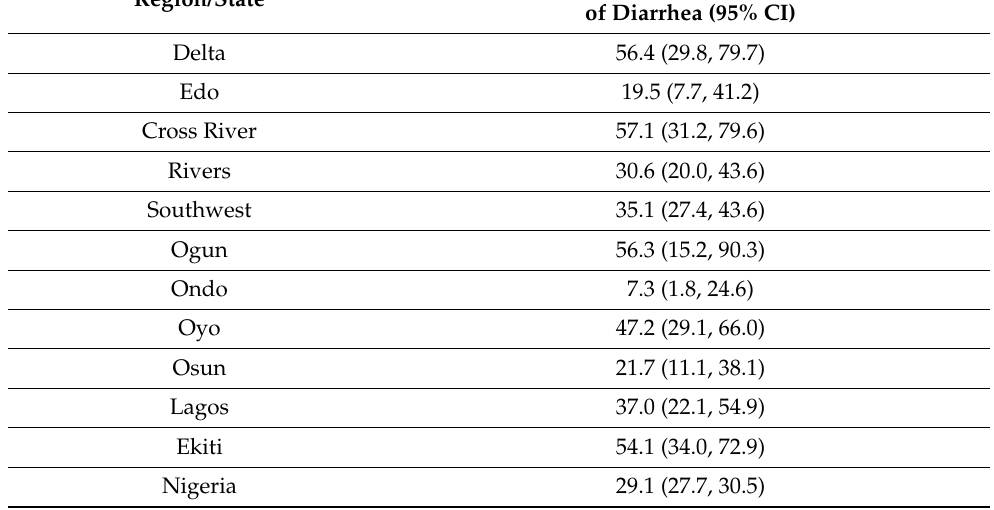
Table A3. Percentage of children with diarrhea during the 2 weeks prior to the survey that were reported to have received oral rehydration solution (ORS) in the 2018 NDH by Regions and